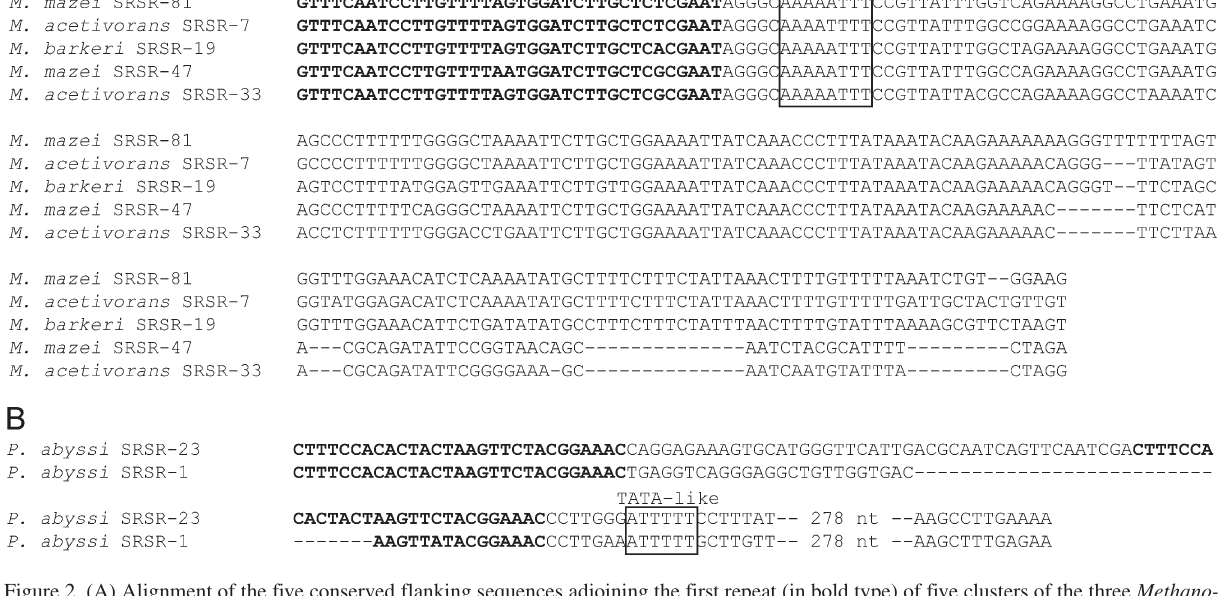
Figure 2. (A) Alignment of the five conserved flanking sequences adjoining the first repeat (in bold type) of five clusters of the three Methano- sarcina strains. A putative TATA-like box is outlined. (B) Alignment of two flanking regions of the P. abyssi genome where paby-1 appears to ex- hibit a defective start